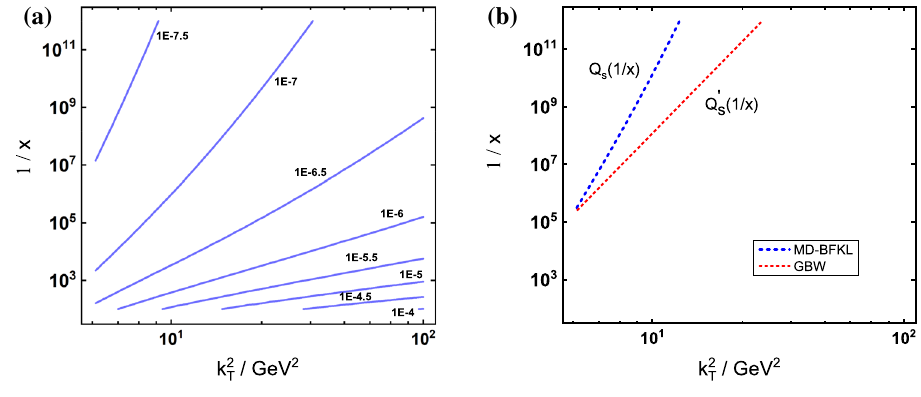
Q s during the approach to saturation regime. This property is known as geometrical scaling in DIS inclusive event which means that instead of depending on k 2 gluondistributiondepends onasingledimensionless variable k 2 T Q 2 s